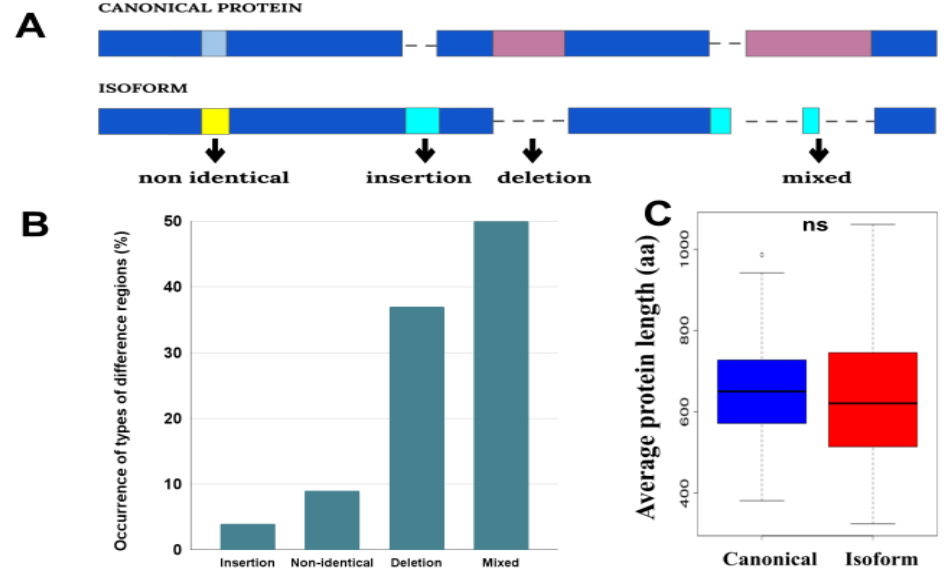
Figure 1. ( A ) Schematic representation of four groups of difference regions (dark blue and pink colors indicate identical and non-identical regions in the sequences, respectively). ( B ) Occurrence of types of the difference regions. ( C ) Distributions of the average length of canonical proteins and isoforms in proteomes. The distributions contain 58 points corresponding to the average length of each proteome. Here, ns means non-significant difference with p -value > 0.05.